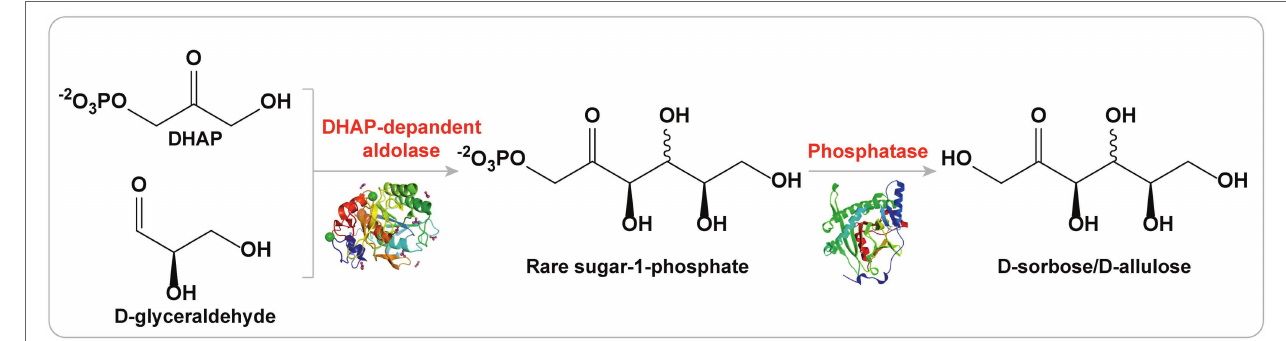
FIGURE 5 | DHAP-dependent aldolases strategy for the production of